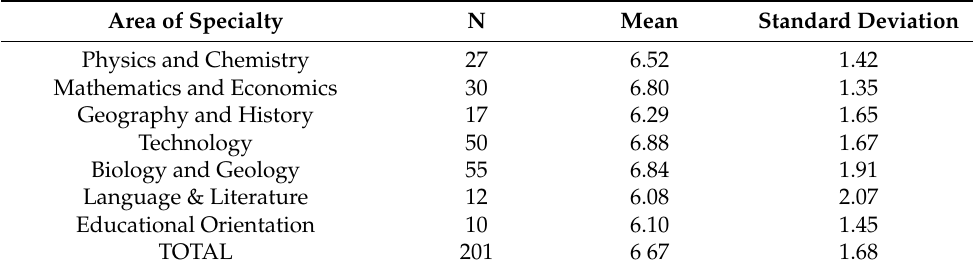
Table 1. The total score obtained in the myths of food according to academic specialties. Area of Specialty N Mean Standard Deviation Physics and Chemistry 27